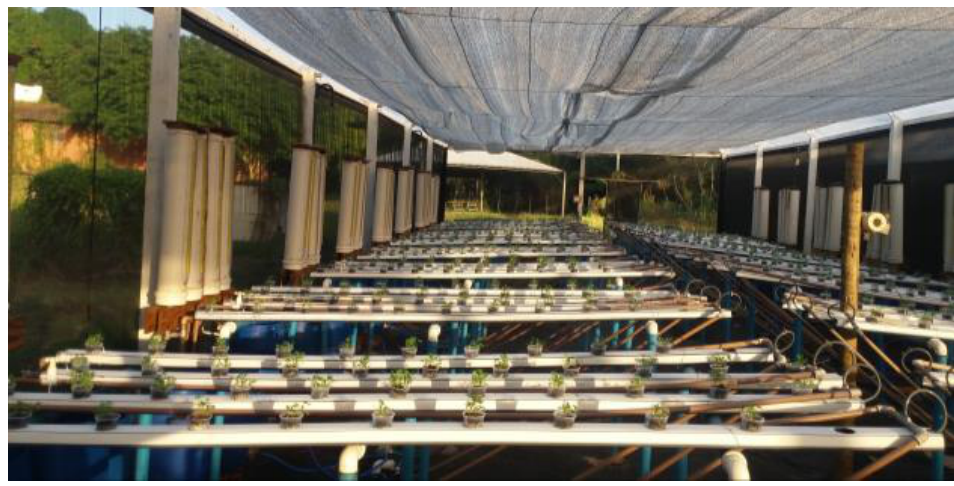
Figure 2. Arrangement of the plants in the hydroponic system.